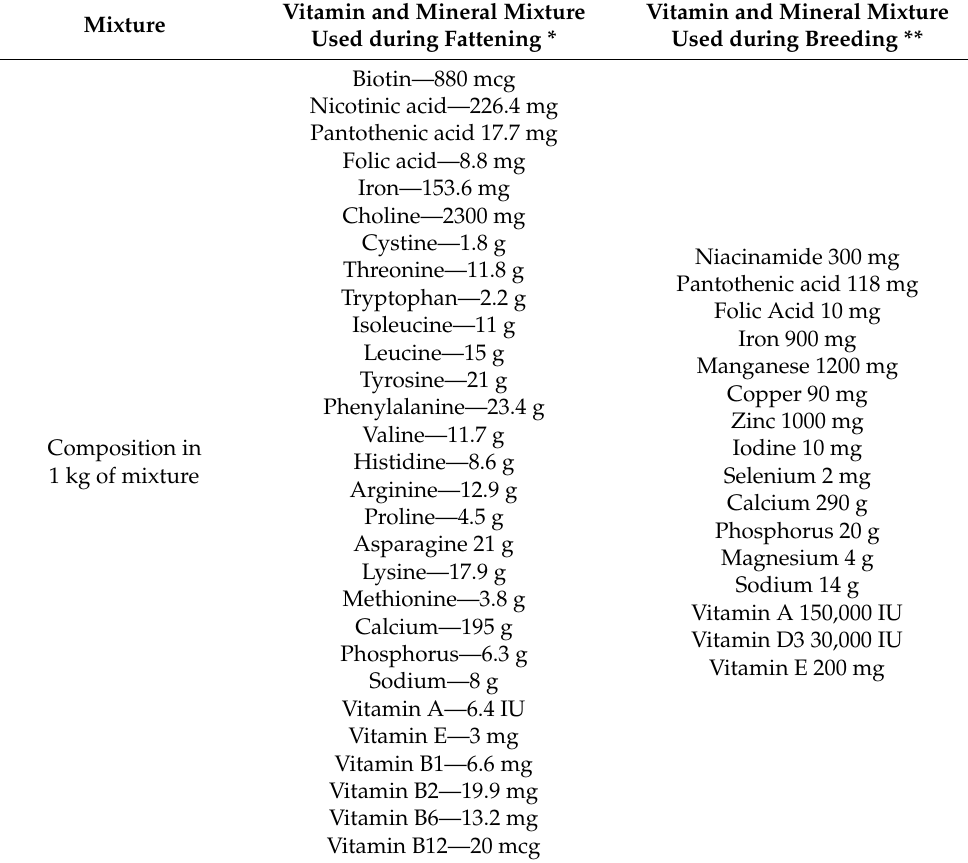
Table 5. The composition of exemplary vitamin and mineral mixtures used for snails.